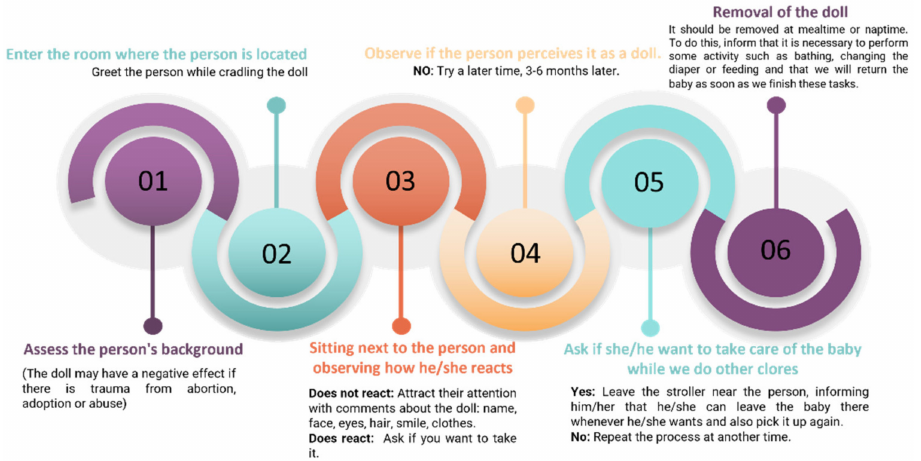
Figure 4. Intervention protocol with Doll